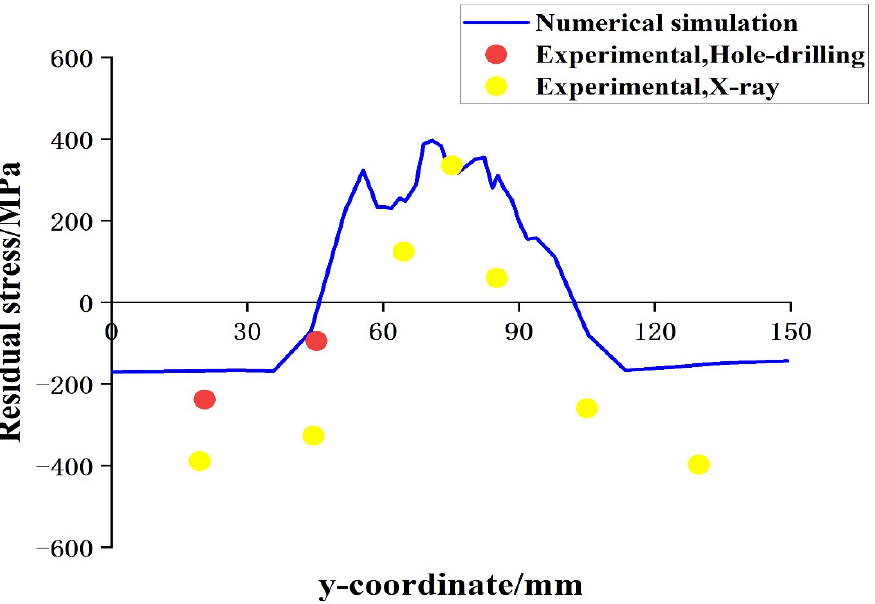
Figure 7. Longitudinal residual stress distributions (Figure 1, lines A–B) obtained using the numerical simulation, X-ray diffraction, and hole-drilling method.